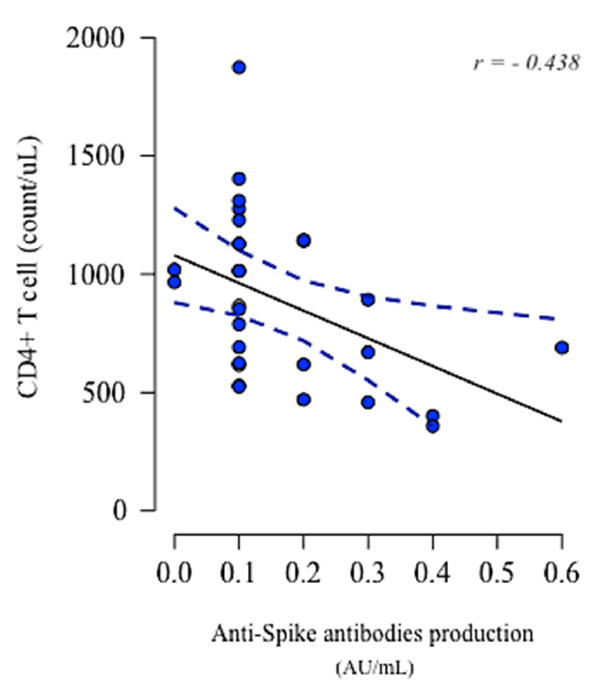
Figure 5. CD4+ T cells and their association with anti-spike IgG production. Negative correlation was found between CD4+ T cells (count/uL) and anti-spike IgG production (AU/mL) in non-seroconverted o-pwMS ( r = − 0.438, p = 0.014, Pearson correlation). Data point (in blue) indicated CD4+ T cells in individual samples and the dashed trend lines (in blue) indicate a negative correlation